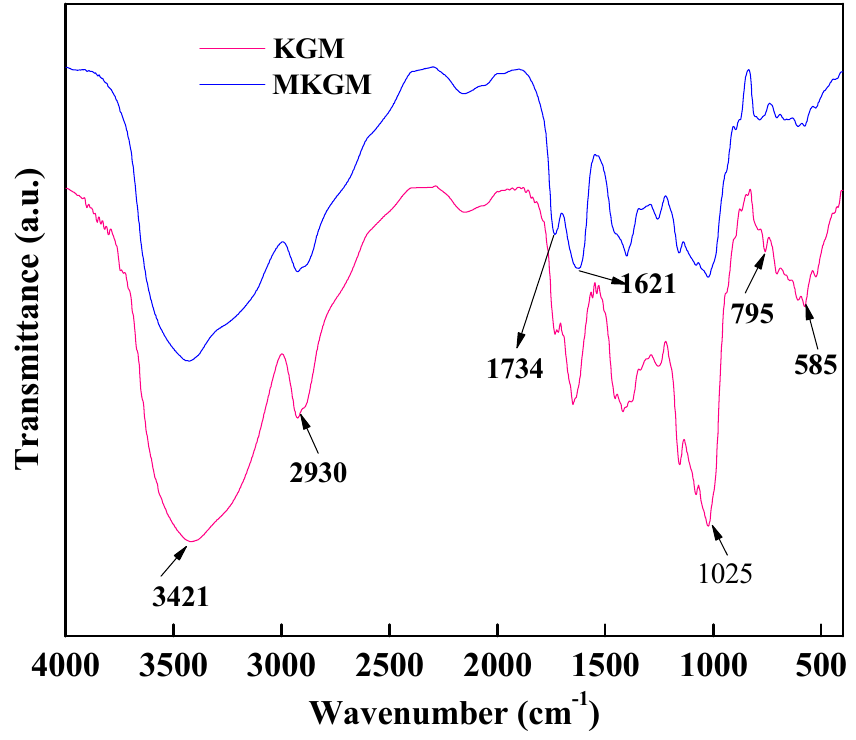
Figure 2. ATR-FTIR spectroscopy of KGM and MKGM. Compared to KGM, the ATR-FTIR spectrum of MKGM at 873 and 807 cm − 1 was not changed, which indicated that the backbone of the primary structure of MKGM was not changed during the modification reaction. The remarkable band at 1734 cm − 1 was at- tributed to the carboxymethyl group, which showed that the etherification modification oc- curred. The band at 1621 cm − 1 was due to the asymmetric absorption band of the carboxyl group. The results illustrated that MKGM was obtained through etherification